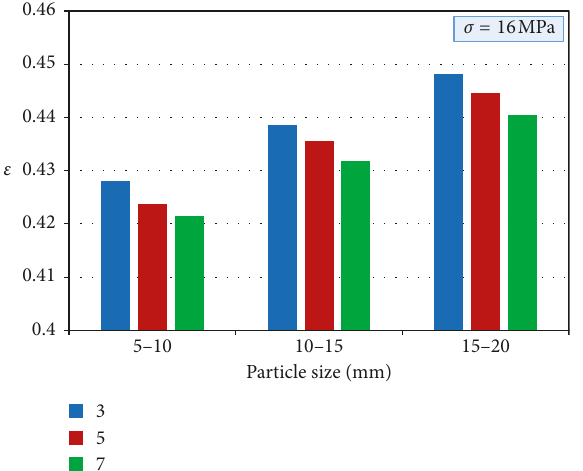
Figure 8: Comparison of strain values of coal gangue at stress of